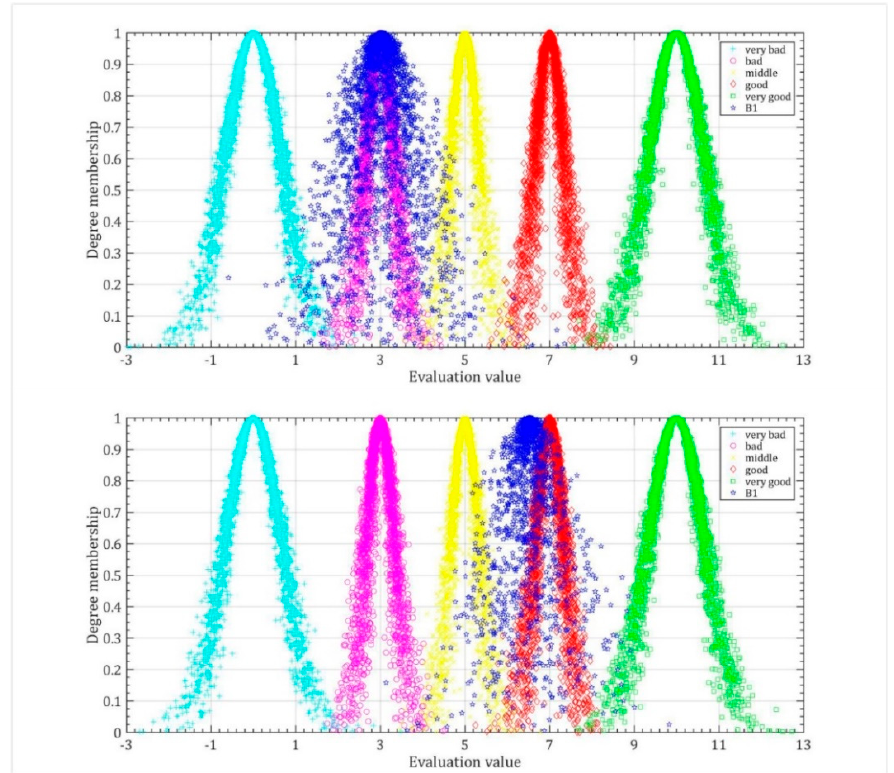
Figure 10. Cloud image of welfare evaluation grades of family's financial situation of land-lost farmers' households under different livelihood assets.